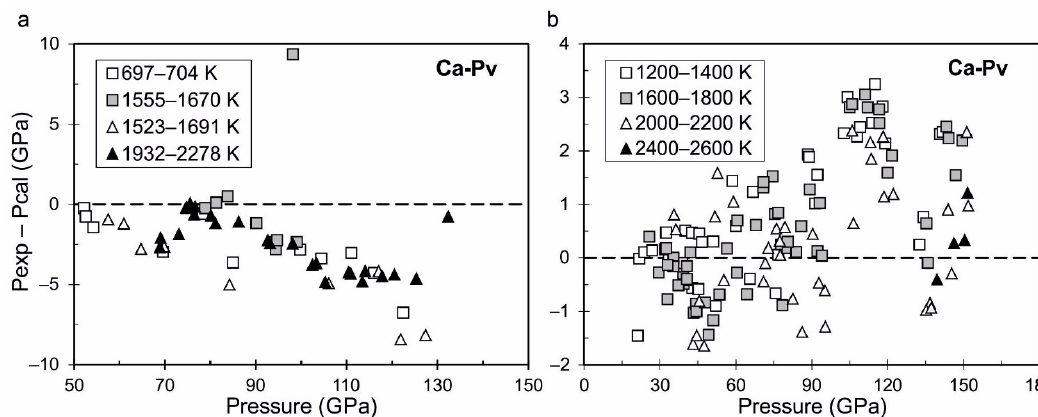
Figure 4. Difference between experimental measured pressure in [63] ( a ) and in [60] ( b ) and calculated pressure from the proposed equation of state of Ca-perovskite at different isotherms. The pressure in [63] is recalculated from the equation of state of Pt [65]; pressure in [60] is determined using the equation of state of Pt [66].